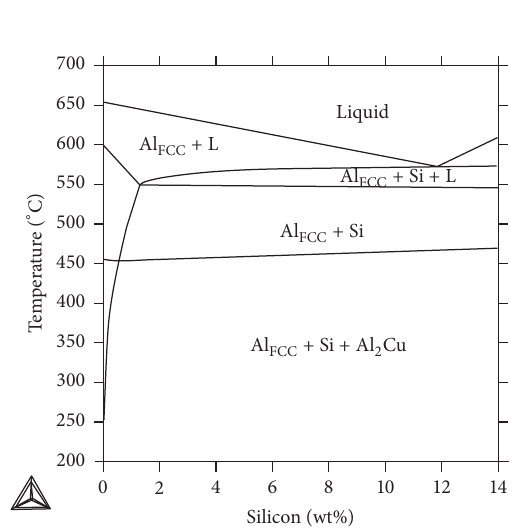
Figure 2: Expected phase diagram for the Al-4.0wt%Si-2.5wt%Cu